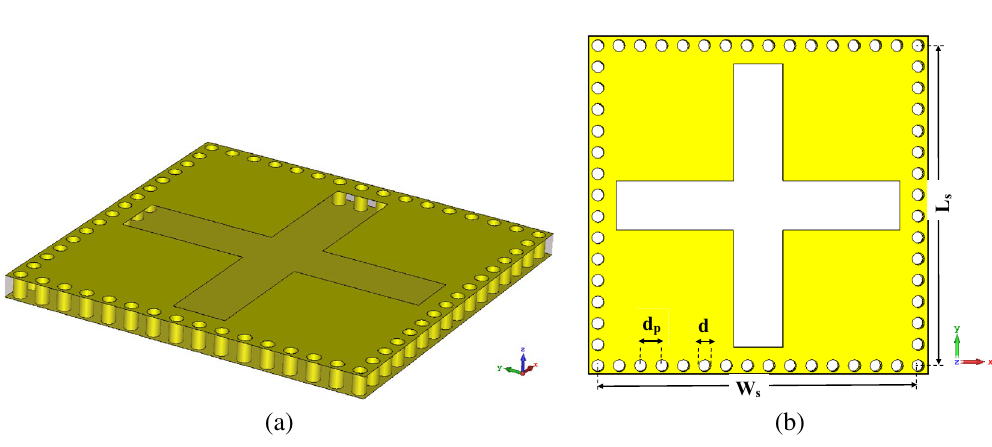
Figure 2. ( a ) Effect of changing slots width , ( b ) Effect of changing slots length.